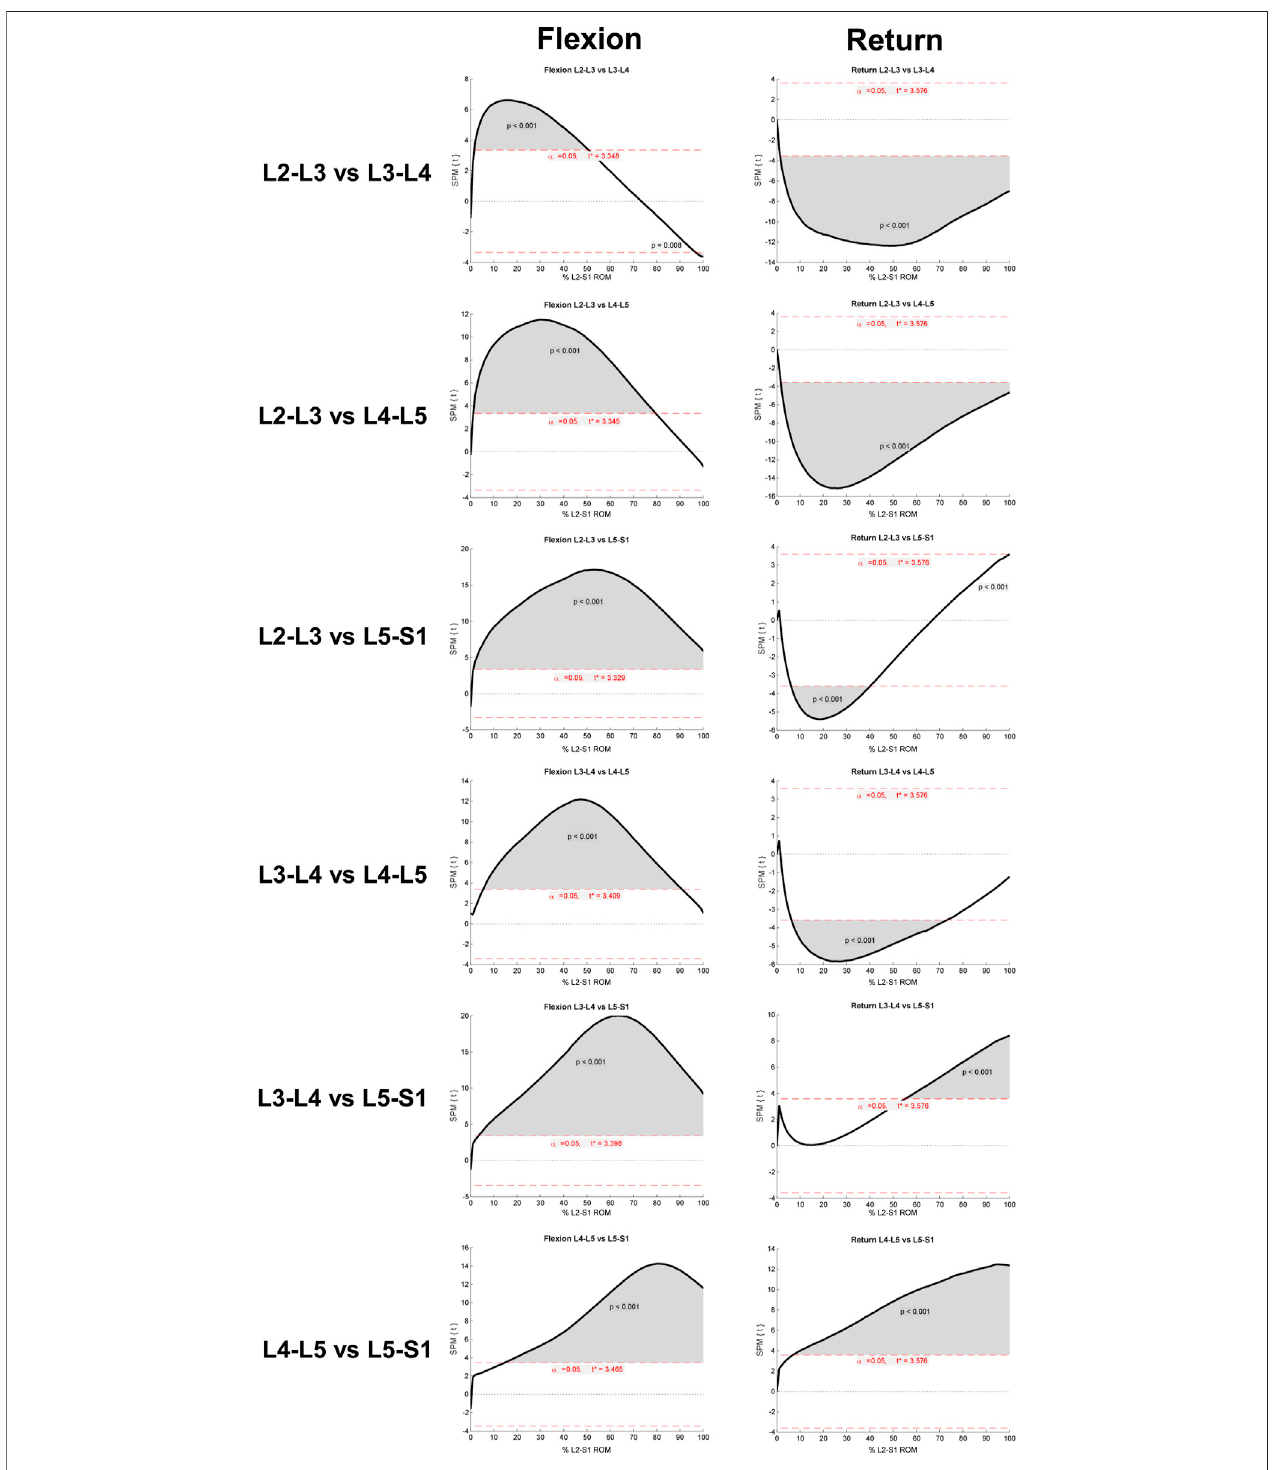
FIGURE 4 | Results of SPM parametric paired t-test (SPM{t}). Each row refers to a different intervertebral joint combination. Supra-threshold clusters indicate signi fi cance differences between joint contributions to motion and are shown in grey. The critical threshold is shown as a red dashed line. Versions of these fi gures alongside the mean and 95%CI bands can be found in Supplementary Material II .